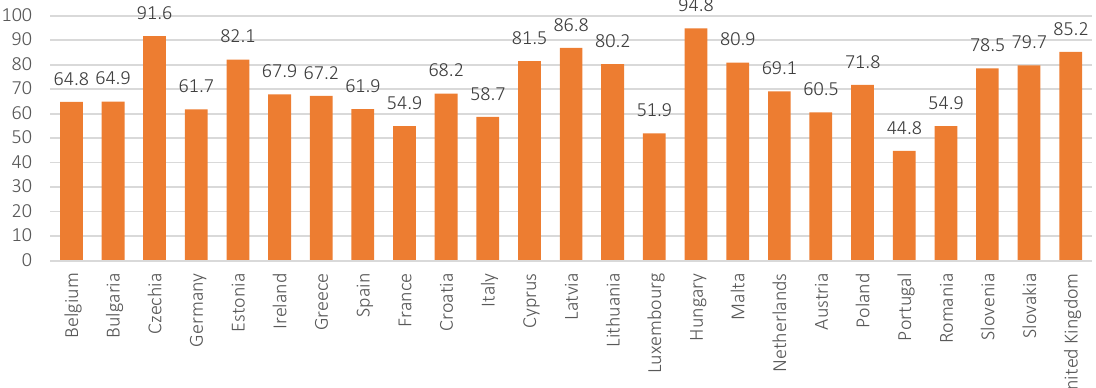
Figure 4. Employed persons who can usually easily take one or two days off at a short notice by working at home, by countries in %